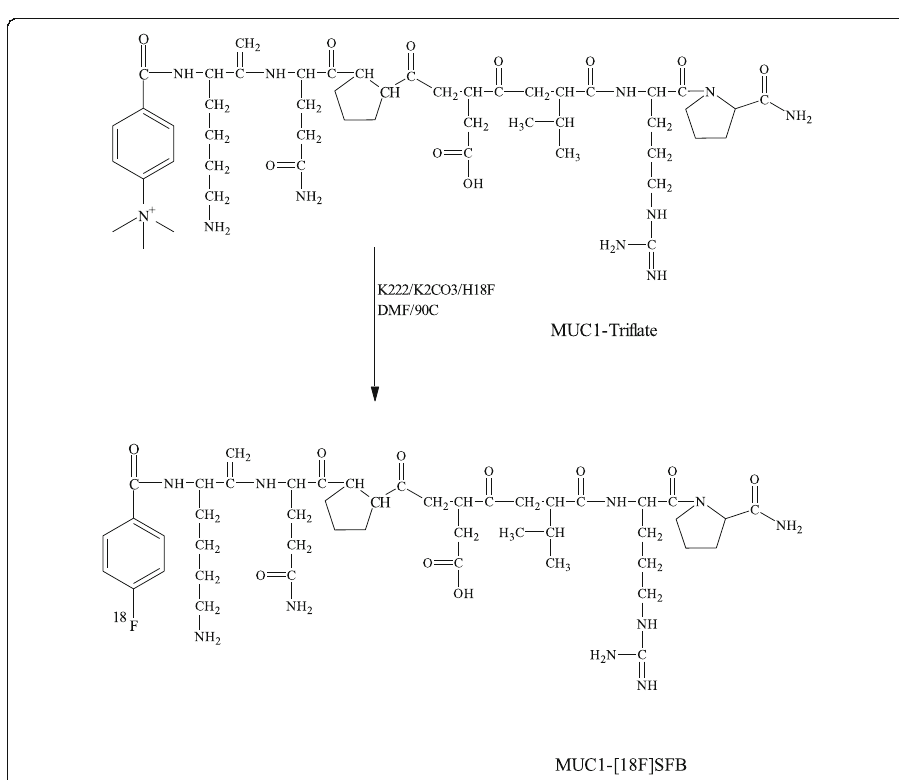
In vitro cell binding The cell-binding activity of the MUC1-[ 18 F] SFB and MUC1-FA-[ 18 F] SFB hybrid peptide conjugates were measured on the human MCF7 breast cancer cell line (ATCC, Rockville, MD). MCF7 cell line was grown in RPMI-1640 culture media with 10% fetal bovine serum (FBS) in tissue culture flasks. 24 h prior to conducting the cell-binding assay, media was replaced with RPMI-1640 without further addition of FBS. Confluent cultures were harvested by trypsinization, and 6 × 10 6 cells were suspended in 1.8 mL of sterile saline for binding assay. Approximately 300,000 cells (in 0.3 mL of sterile saline) were incubated with various amounts of the purified MUC1-[ 18 F] SFB and MUC1-FA-[ 18 F] SFB hybrid peptide conjugates ranging from 0.3 – 18 nM in duplicate for 60 min at room temperature. Incubation was terminated by dilution with cold saline (0.3 mL) and cells were pelleted by centrifugation. The cell-pellets were then washed with cold saline to remove un- bound radioactivity and centrifuged to collect supernatants. Radioactivity in the cell-pellets (total bound) and washings (unbound) were measured in a γ -well coun- ter. Non-specific binding was determined in the presence of approximately 100- fold excess of each unlabeled MUC1 and unlabeled MUC1-FA- hybrid peptide. Specific binding was calculated by subtracting the non-specific bound radioactivity from that of the total binding. The data were analyzed by a non-linear regression analysis program (Graph-Pad Software Inc., San Diego, CA, USA). All binding data were corrected for non-specific binding and presented as the mean ± S.D. The ex- periments were repeated 3